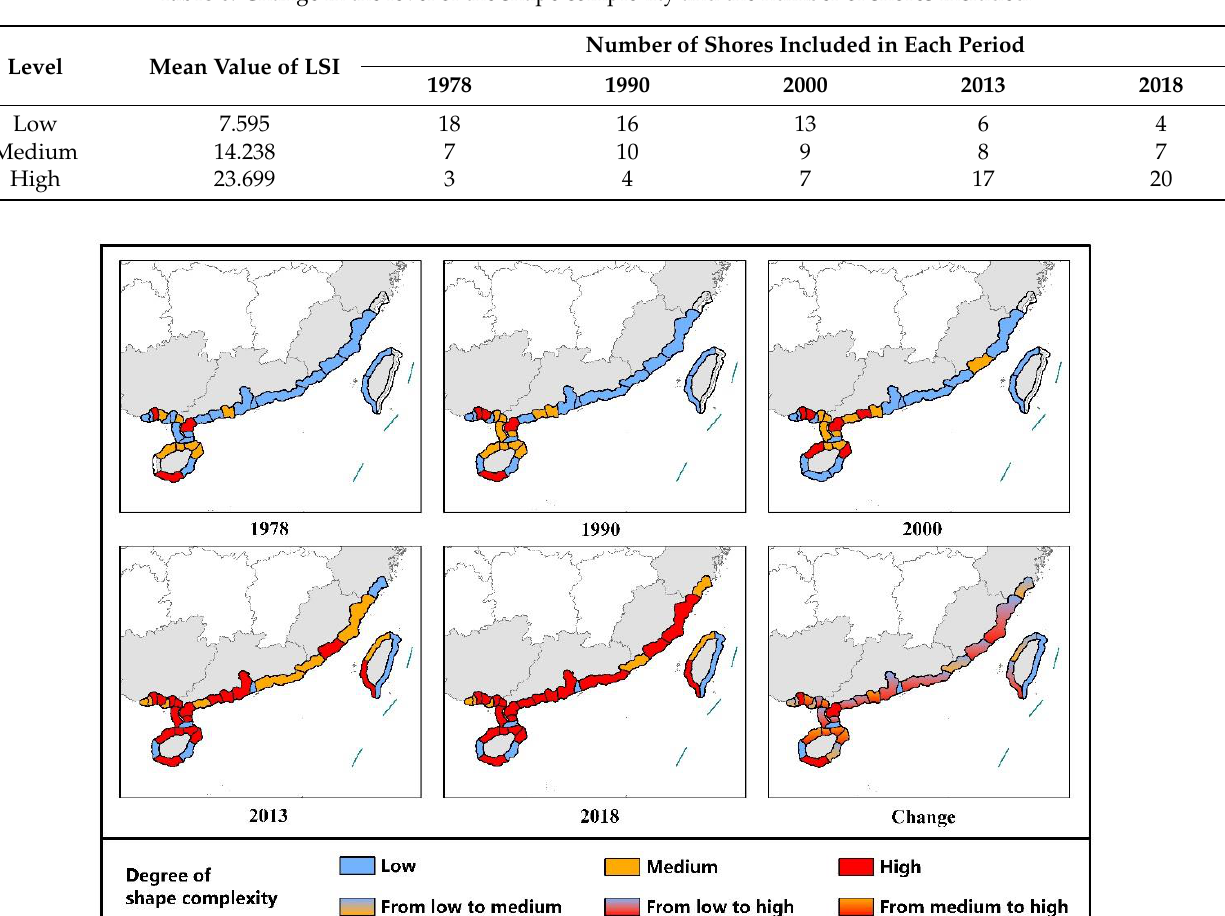
Table 6. Change in the level of the shape complexity and the number of shores included.